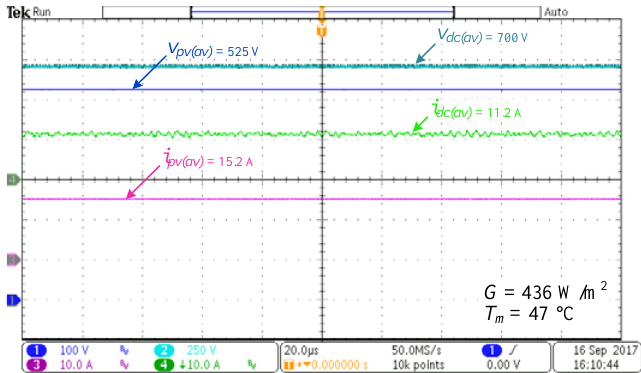
Figure 30. A sample set of v pv ( av ) , i pv ( av ) , v dc ( av ) and i dc (av) waveforms recorded at G = 436 W/m 2 , and T m = 47 °C. Experimental efficiency values for the SiC VSI calculated from field data for different P o ( MPPT )